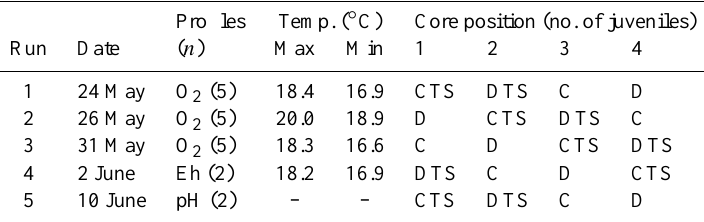
Table 1. Date of sediment collection in 2011, type and number of pore water microprofiles measured in each core, maximum and minimum flume seawater temperature during the Runs and allocation of sediment core treatments to each of the four core positions. Profiles Temp. ( ◦